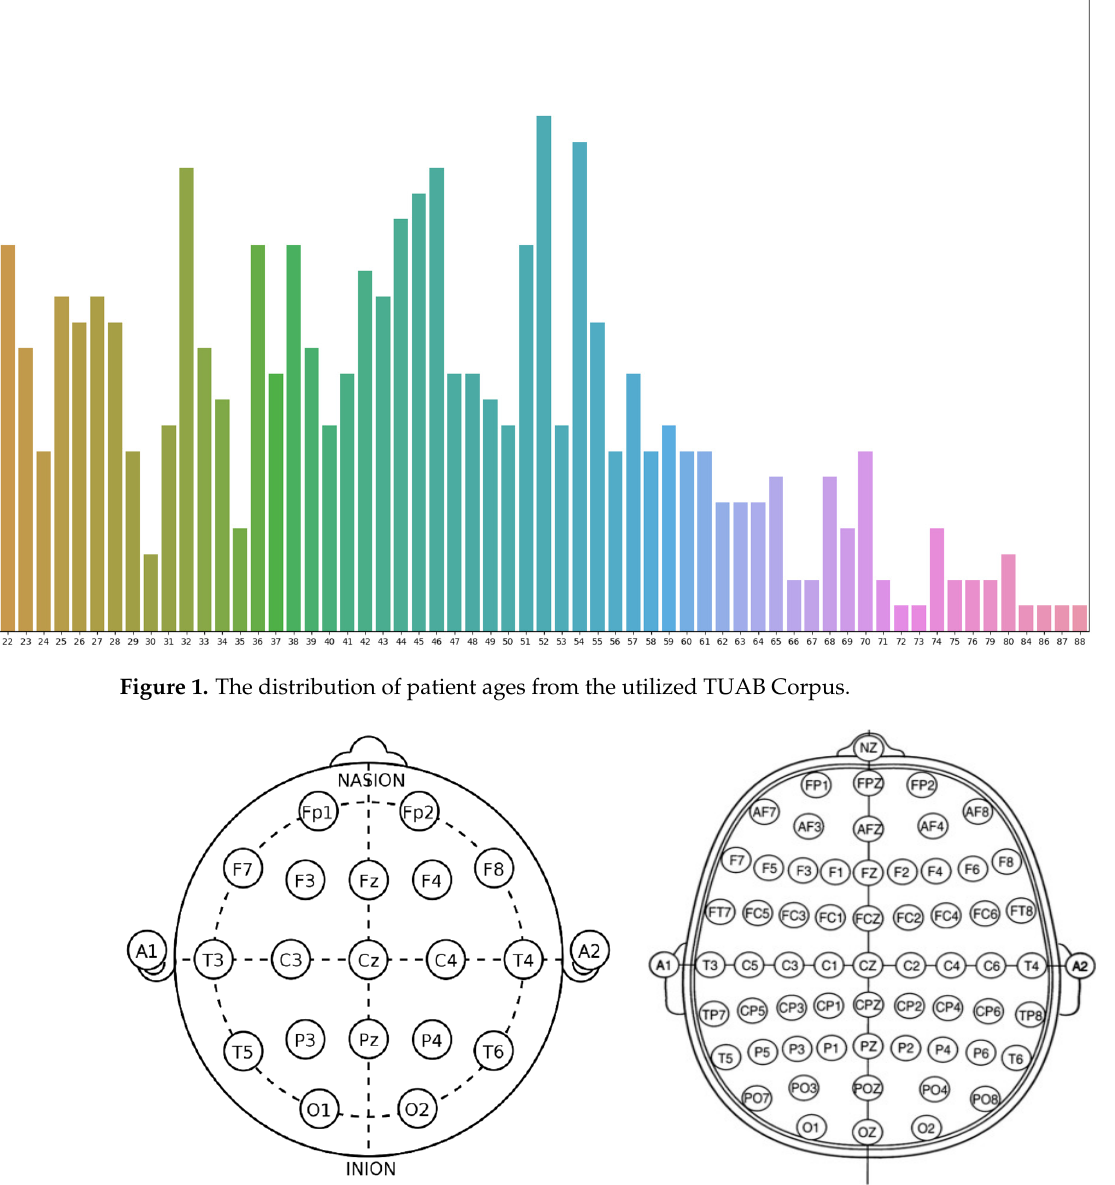
Figure 1. The distribution of patient ages from the utilized TUAB Corpus.